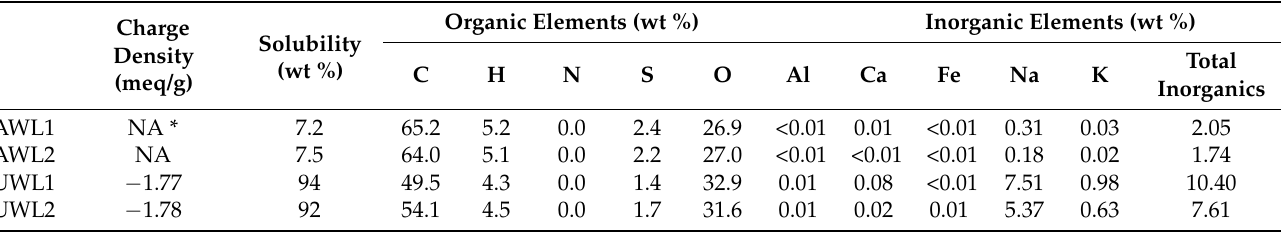
Table 1. Properties of unmodified softwood kraft lignin samples.